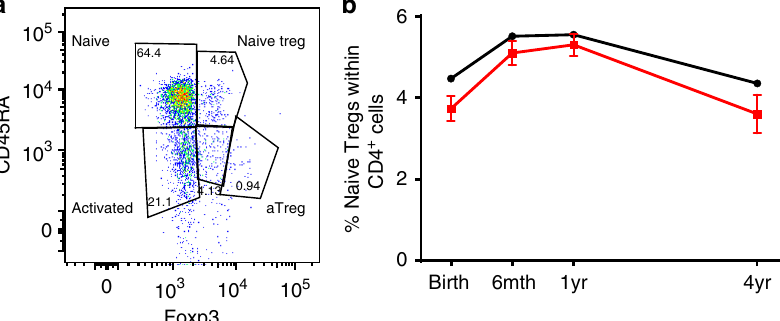
Fig. 3 Naive Treg cell changes in infants exposed to preeclampsia. BIS study : a Representative dot plot showing the gating strategy for naive Tregs gated on CD4 + cells. b The line graphs showing the longitudinal naive Treg cell proportions (Mean ± SD, as a percentage of the CD4 + population) in children from preeclamptic mothers (Red: at birth n = 11; 6-month n = 19; 1-year-old n = 22; 4-year-old n = 10) and children from non-hypertensive mothers (Black: at birth n = 434; 6-month n = 558; 1-year-old n = 629; 4-year-old n = 377). The overall difference is – 0.49% (95% CI – 0.83, – 0.16) ( p = 0.004,